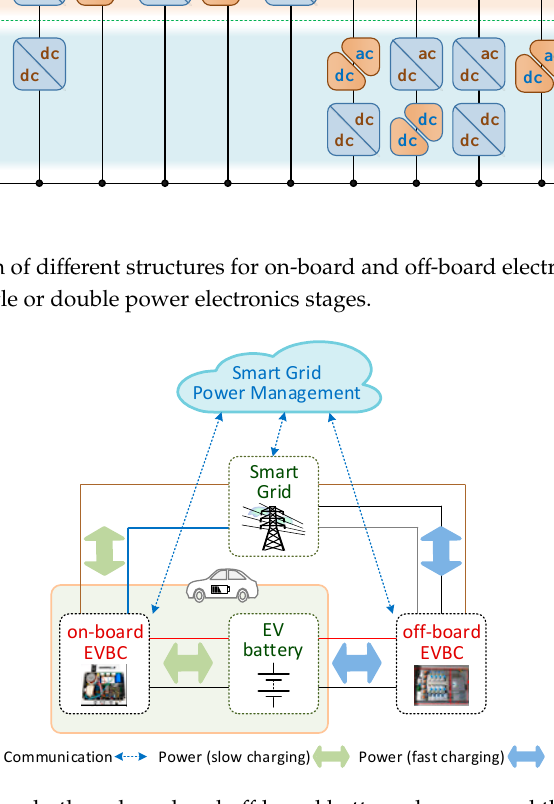
Figure 2. EV considering both on-board and off-board battery chargers and the respective interface with the electrical power grid, allowing bidirectional power flow and communication.